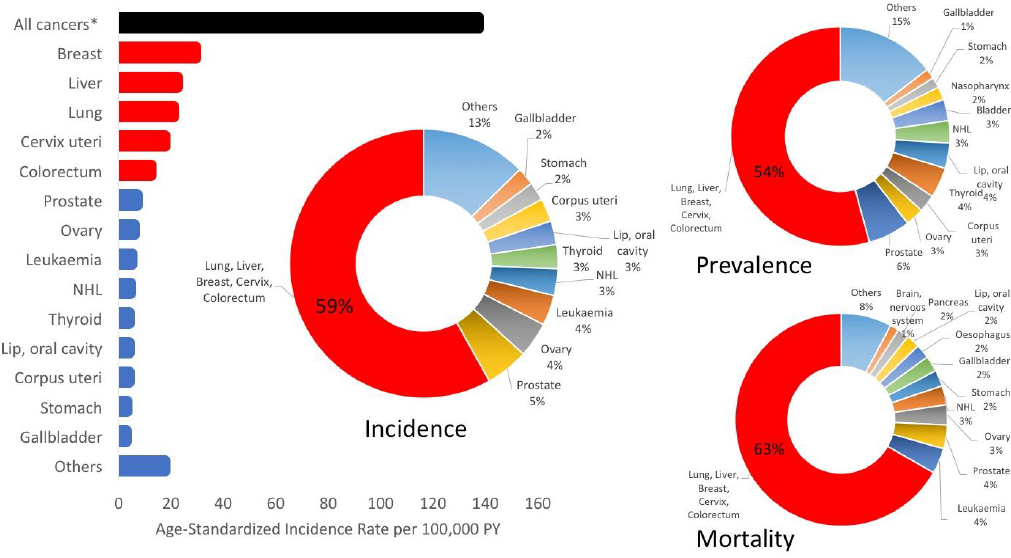
Figure 1. Breast, cervix, colorectal, liver and lung cancers combined had the highest age-standardized rates in 2012 and accounted for more than half of the incidence, prevalence and mortality in Thailand. * excluding non-melanoma skin cancer.